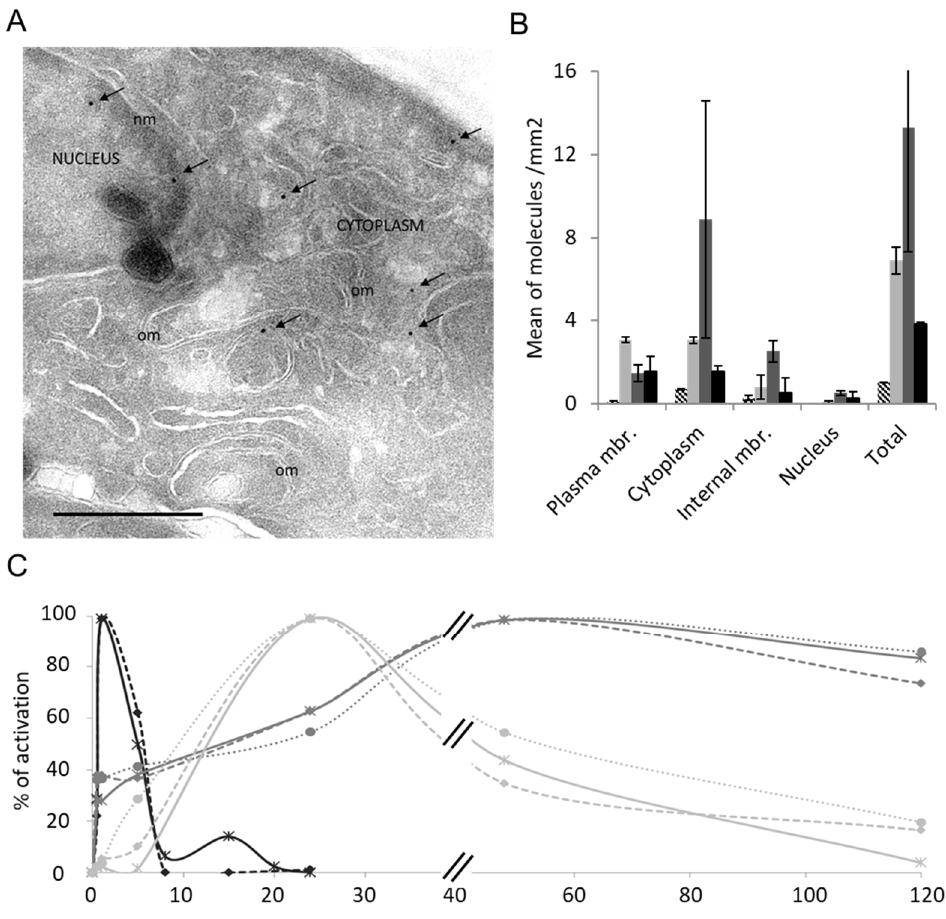
Figure 1. Kinetics of AsiDNA uptake and ATM, PARP1, and DNA-PK activation. ( A ) SK28 cells were treated with biotinylated AsiDNA and analyzed at different times with electronic microscopy. Typical picture after 5 h of AsiDNA treatment. Arrows indicate gold-streptavidin beads bound to biotinylated AsiDNA. om, organelle membrane; nm, nucleic membrane. Scale bar: 500 nm. ( B ) Quantification of AsiDNA distribution in the plasma membrane, cytoplasm, internal membranes, and nucleus. Cells were untreated (dashed), or treated for 1 h (light gray), 5 h (gray), or 24 h (black) with biotinylated AsiDNA before imaging. The detected signal in the untreated samples was not due to biotinylated AsiDNA but likely due to endogenous biotin. ( C ) Enzyme activation by AsiDNA in three cell lines: SK28 (continuous lines), MRC-5sv (dashed lines), and MDA-MB-231 (dotted lines). The kinetics of ATM autophosphorylation (black) was measured by immunofluorescence quantification on microscopy images. DNA-PK kinase-dependent H2AX phosphorylation (light gray) was measured by Western blot, and PARP1 activation was estimated by PAR quantification with an ELISA test (gray). Relative activation is reported as compared to maximal signal after different times of AsiDNA treatment. Symbols indicate measured data on smooth graphs.